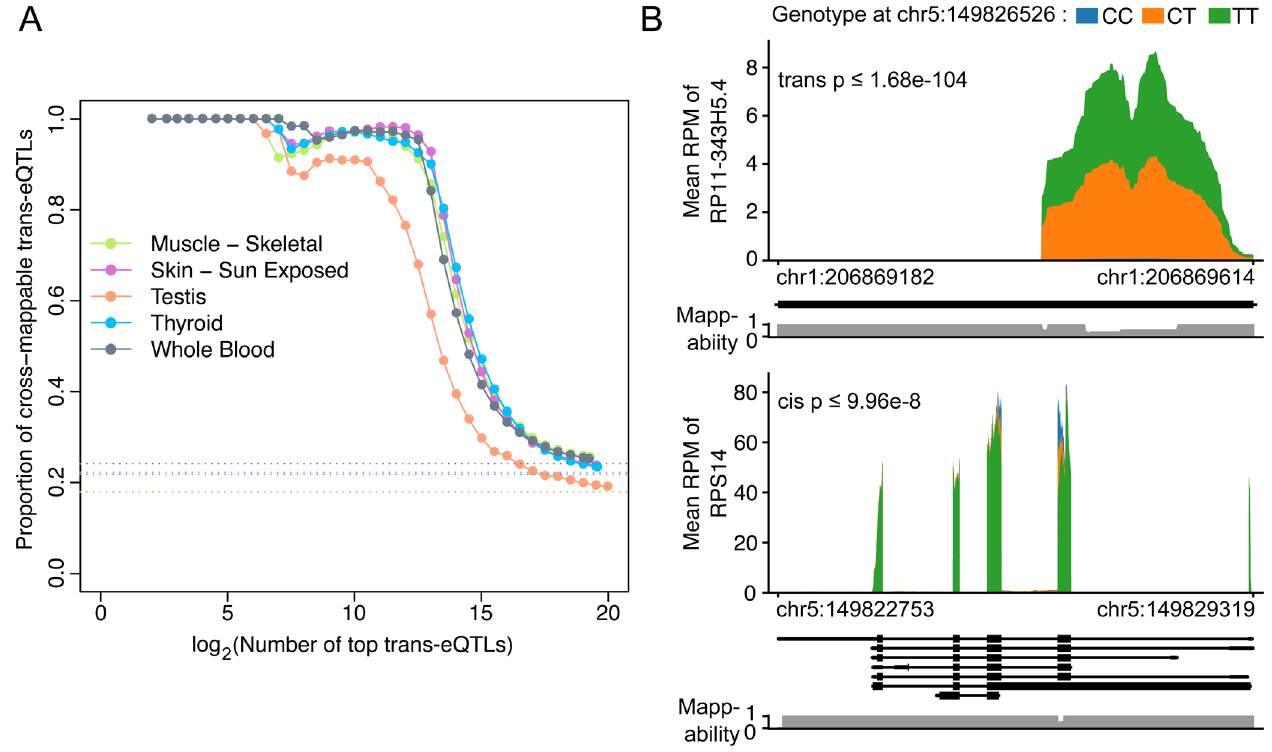
Figure 2. Effect of cross-mappability on trans-eQTLs in GTEx. A ) Fraction of cross-mappable trans-eQTLs among the top significant variant-gene pairs (ordered by increasing FDR) in each tissue (color). Each dotted horizontal line represents the background cross-mappable rate in a given tissue. B ) An example of likely false positive trans association between the variant chr5:149826526 and the gene RP11- 343H5.4. The coverages (reads per million, RPM) of the trans-eGene RP11-343H5.4 (top) and its cross-mapping gene RPS14 (bottom) in Thyroid are shown along with their exons and UTRs (black lines below the coverage plot), and mappability of 75-mers. The regions of mappability less than 1.0 have sequence similar between the two